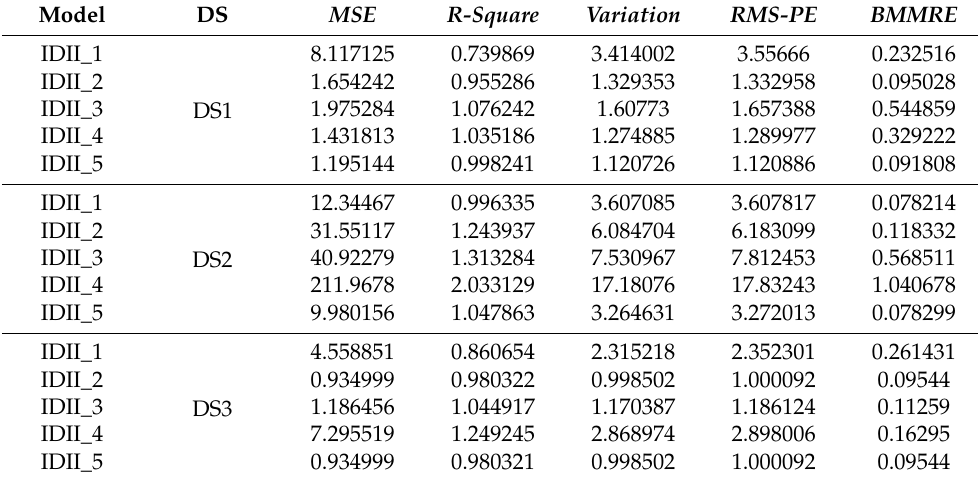
Table 3. Performance comparison of IDII-type